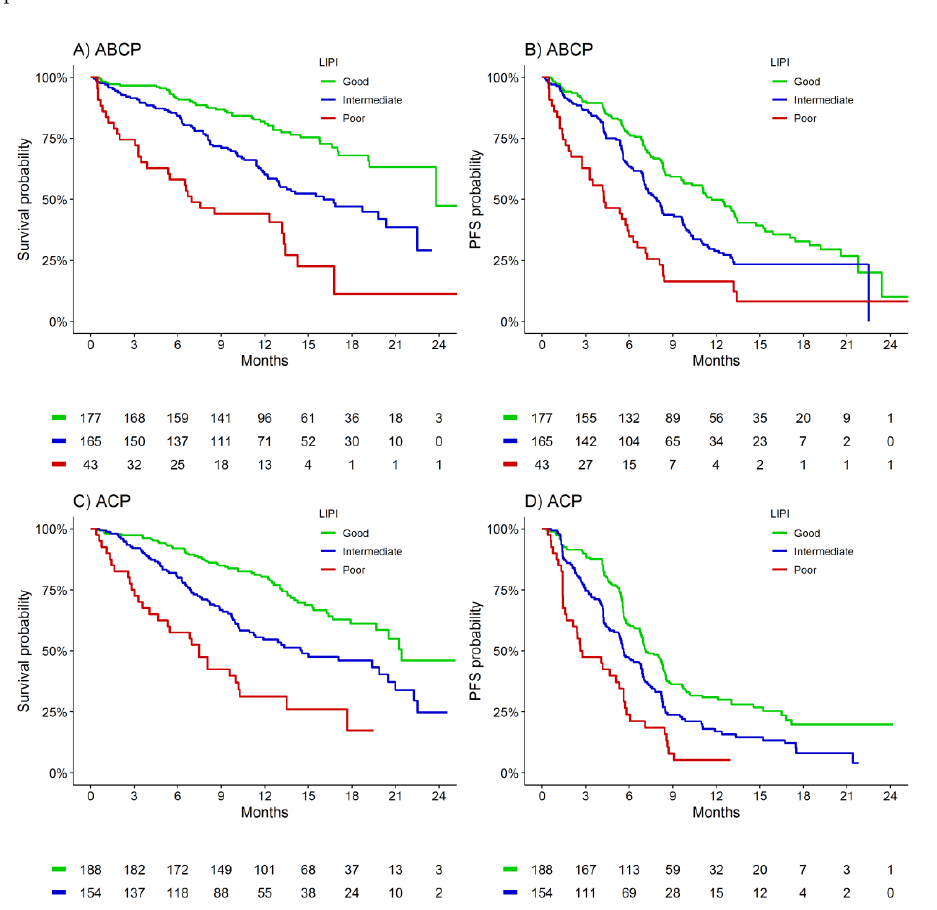
Table 1. Association between lung immune prognostic index (LIPI) and survival outcomes for patients randomized atezolizumab-bevacizumab-carboplatin-paclitaxel (ABCP) or atezolizumab- carboplatin-paclitaxel (ACP).